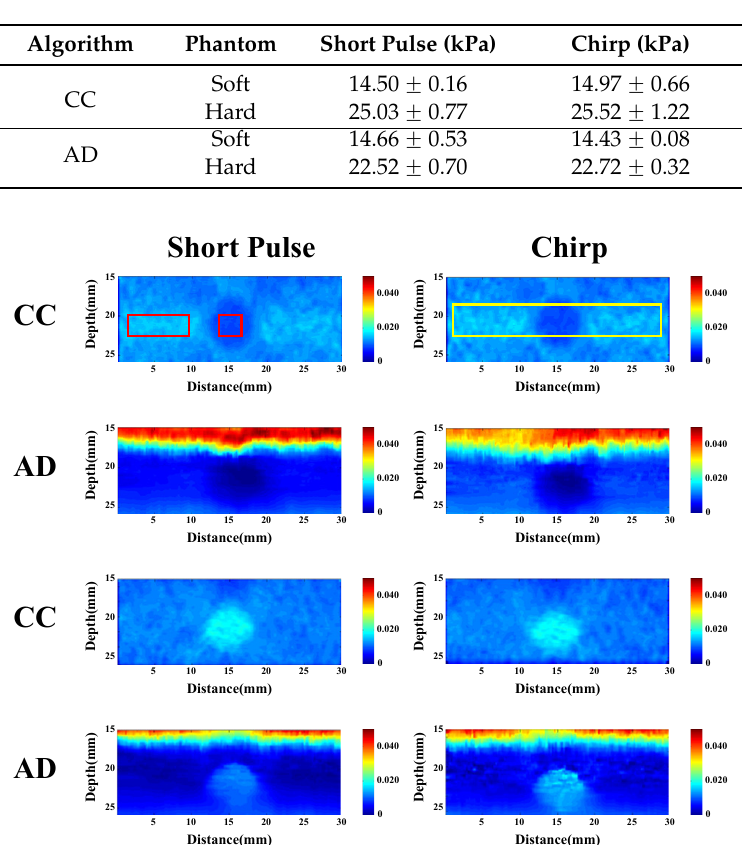
Figure 26. Strain image of two phantoms by CC and AD algorithm.